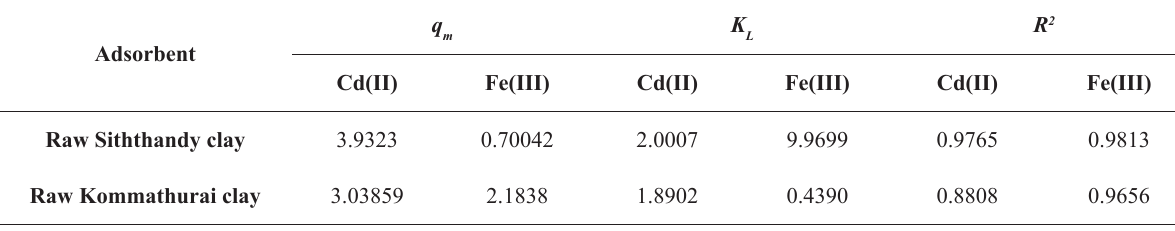
Table 2: Langmuir adsorption isotherm constants for Cd(II) ions and Fe(III) ions adsorption.